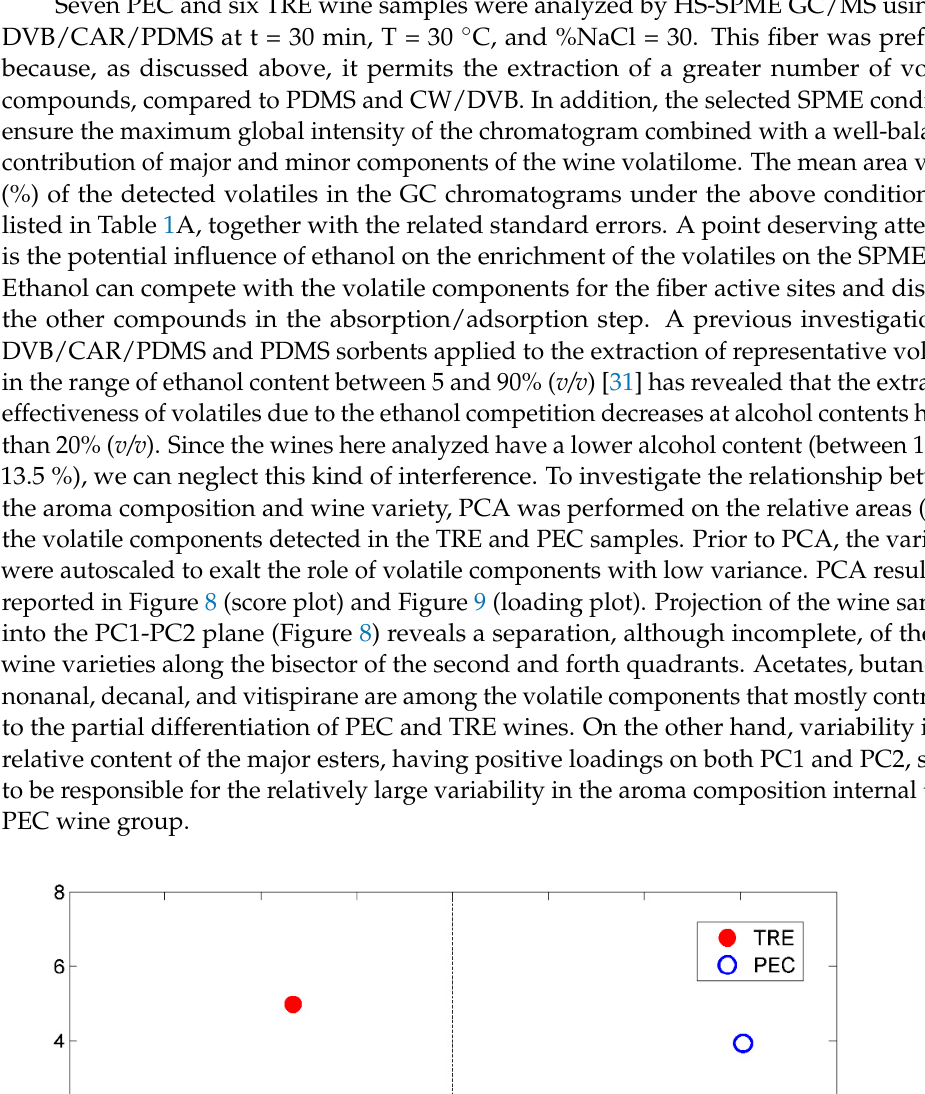
Figure 9. Projection of the variable loadings onto the plane of the first two principal components (PC1 and PC2) extracted from the volatile profiles of PEC and TRE wines collected with the DVB/CAR/PDMS fiber. Preliminary PCA of the volatile profiles of TRE and PEC wine samples reveals that the two wine varieties, although produced with grapes belonging to the same family, ex- hibit a different composition of the aroma profile. Nevertheless, because of the relatively small number of wine samples analyzed here and the explorative nature of PCA, the abil- ity of the volatile profile for the discrimination of mono-varietal wines produced with TRE and PEC grapes has not been demonstrated. The successive development of the present investigation [28], extended to a larger number of TRE and PEC samples representing the four Abruzzo provinces, and including a third wine variety belonging to the family of